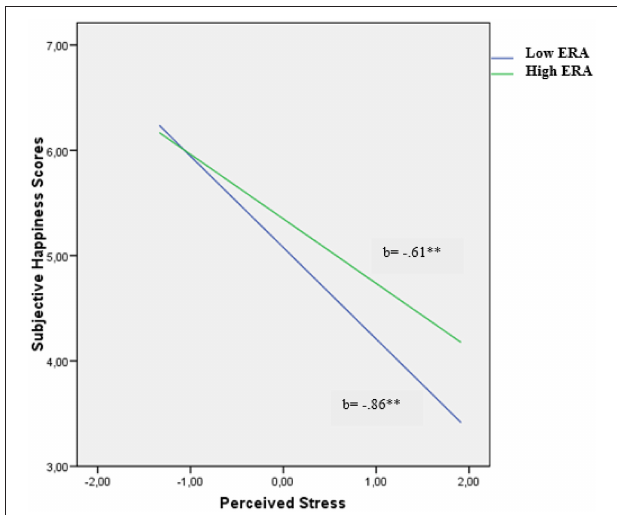
FIGURE 2 | Relationship of perceived stress and emotion regulation ability for predicting subjective happiness scores in males. ** p < 0.01